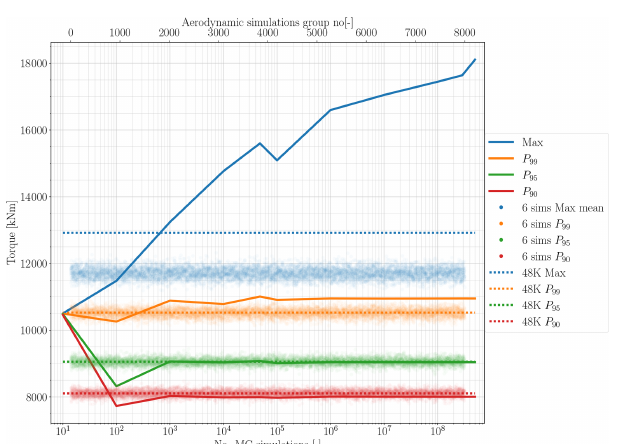
Table 3. The computational time required to run aerodynamic simulations, building the surrogate models, and the average Hellinger distance. Case No. of Simulation Computation Time required to build aerodynamic length time one surrogate model sims Sims for PCE P = 4 2002 1s 10s Sims for PCE P = 5 6006 1s 31s Common practice 6 600s n/a Reference case 48000 600s 41h 55min 48s n/a n/a – not applicable.